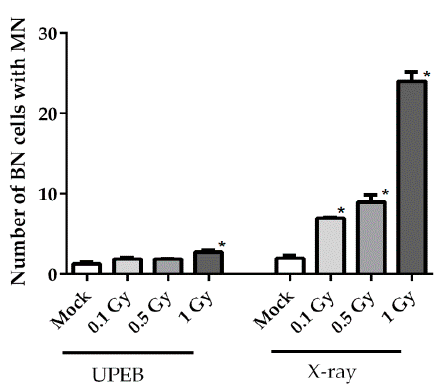
Figure 4. Incidence of micronuclei (MN) formation per 1000 binucleated (BN) cells (‰) in the MRC5 cell line after UPEB and X-ray irradiation. Data represent the mean ± standard error of the results of three independent experiments. * p < 0.05 in comparison to the corresponding control (mock-irradiated cells).